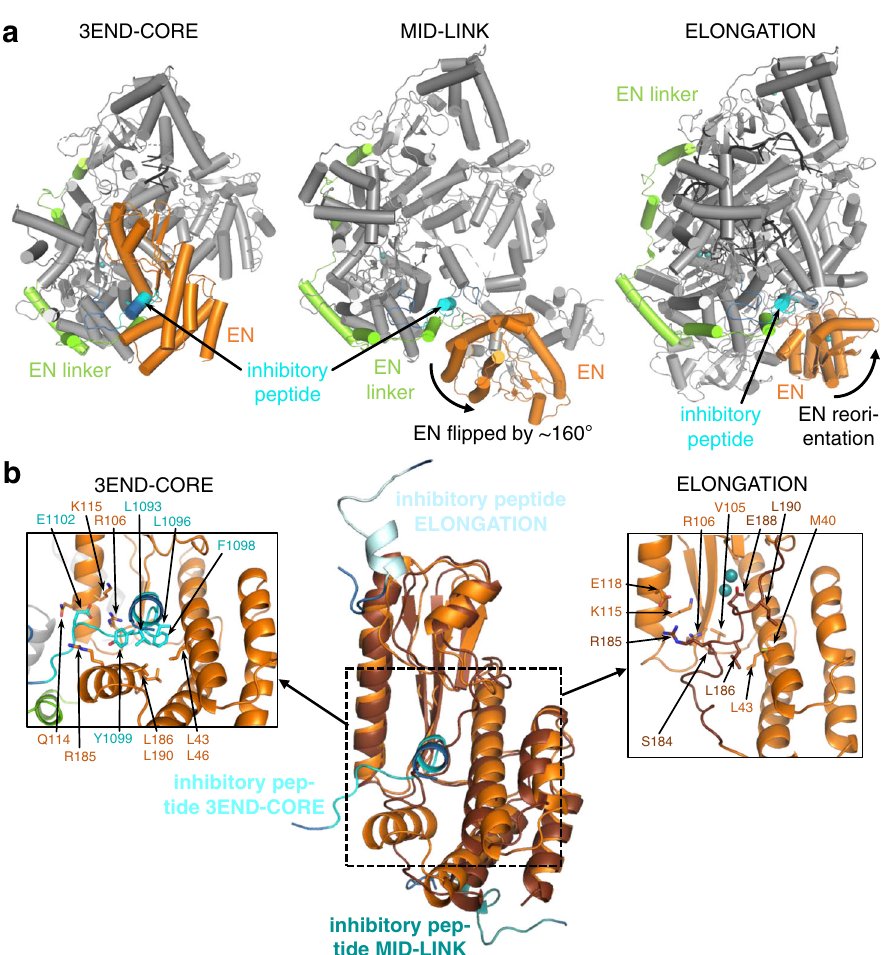
Fig. 5 Conformational fl exibility of the endonuclease domain. a Overview of the three different conformations of the EN (orange) observed in the 3END- CORE, MID-LINK and ELONGATION structures. The EN linker (green) and the inhibitory peptide (cyan) are highlighted as well. b In the middle panel a superimposition of the EN domains of 3END-CORE (orange), corresponding also to the overall conformation of the EN domain in the MID-LINK structure, and ELONGATION (brown) with the respective positions of the inhibitory peptides in teal, cyan and light blue, respectively, is shown. Connections to the fi ngers domain are indicated in blue. The position of the inhibitory peptide of 3END-CORE is the same as in the APO-ENDO structure, similarly is the same position of the EN observed in both MID-LINK and DISTAL-PROMOTER structures. Right and left panels show close-ups of the autoinhibited EN active sites in the ELONGATION and 3END-CORE structures, respectively. Important residues of the protein-protein interactions are labelled and side chains are shown as sticks. For a focus on the inhibitory loop in the different conformations see Supplementary Fig.